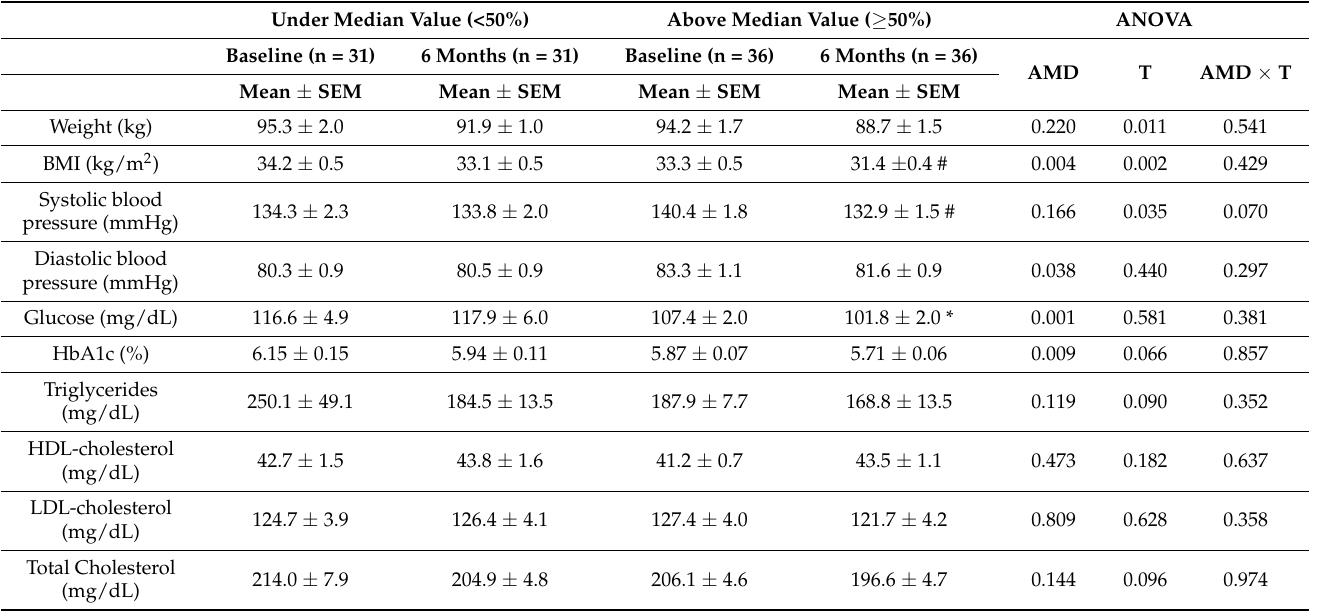
Table 3. Anthropometric and biochemical characteristics of participants “Baseline” and “6 months” stratified by adherence to Mediterranean